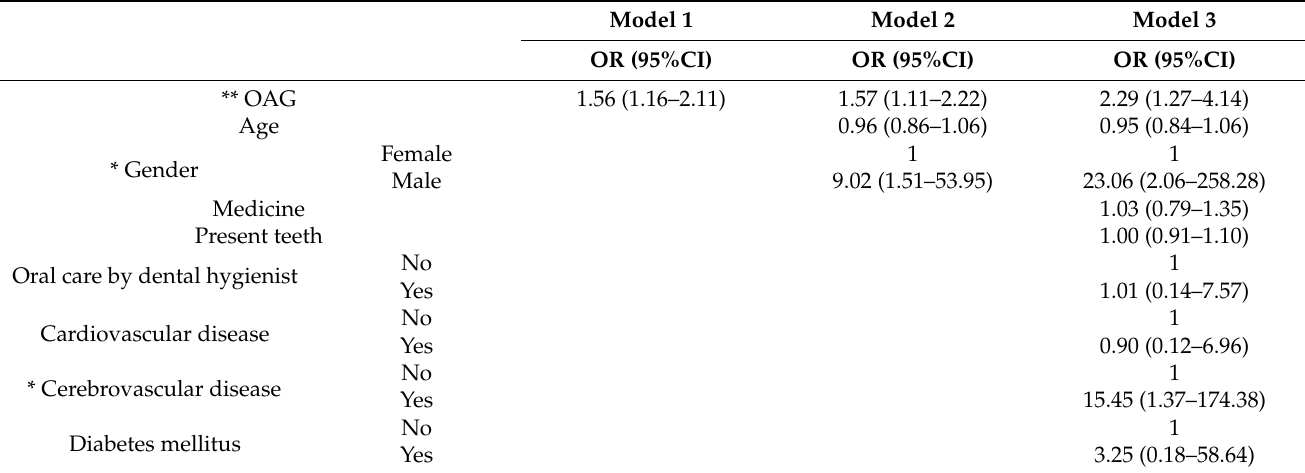
Table 4. Multiple logistic regression